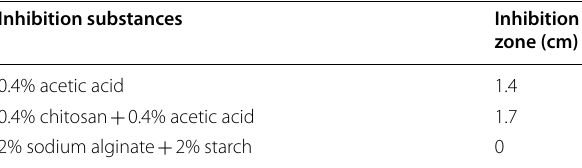
Table 5 Effect of the capsule components on the area of inhibition zone of P. l. larvae